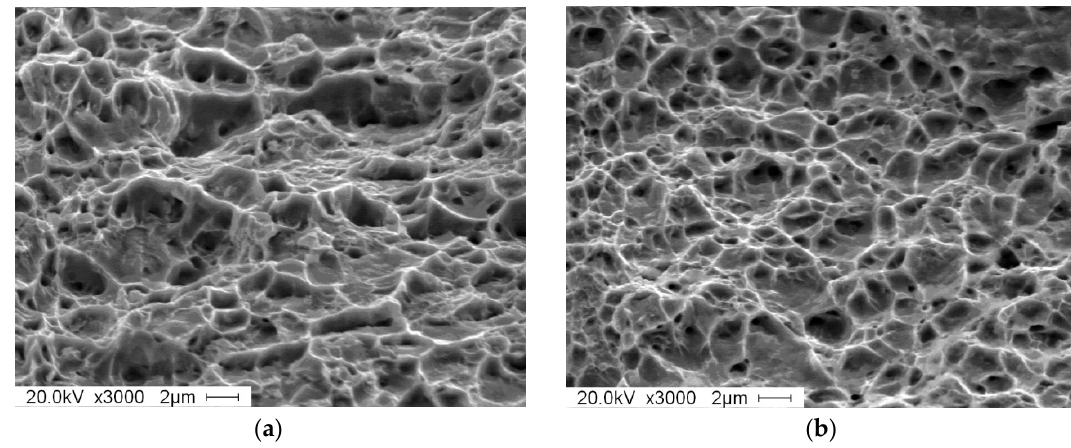
Figure 5. Surface of specimens after two heat treatments: ( a )Dual Process (DP) steel; ( b ) Transformation Induced Plasticity (TRIP) steel.